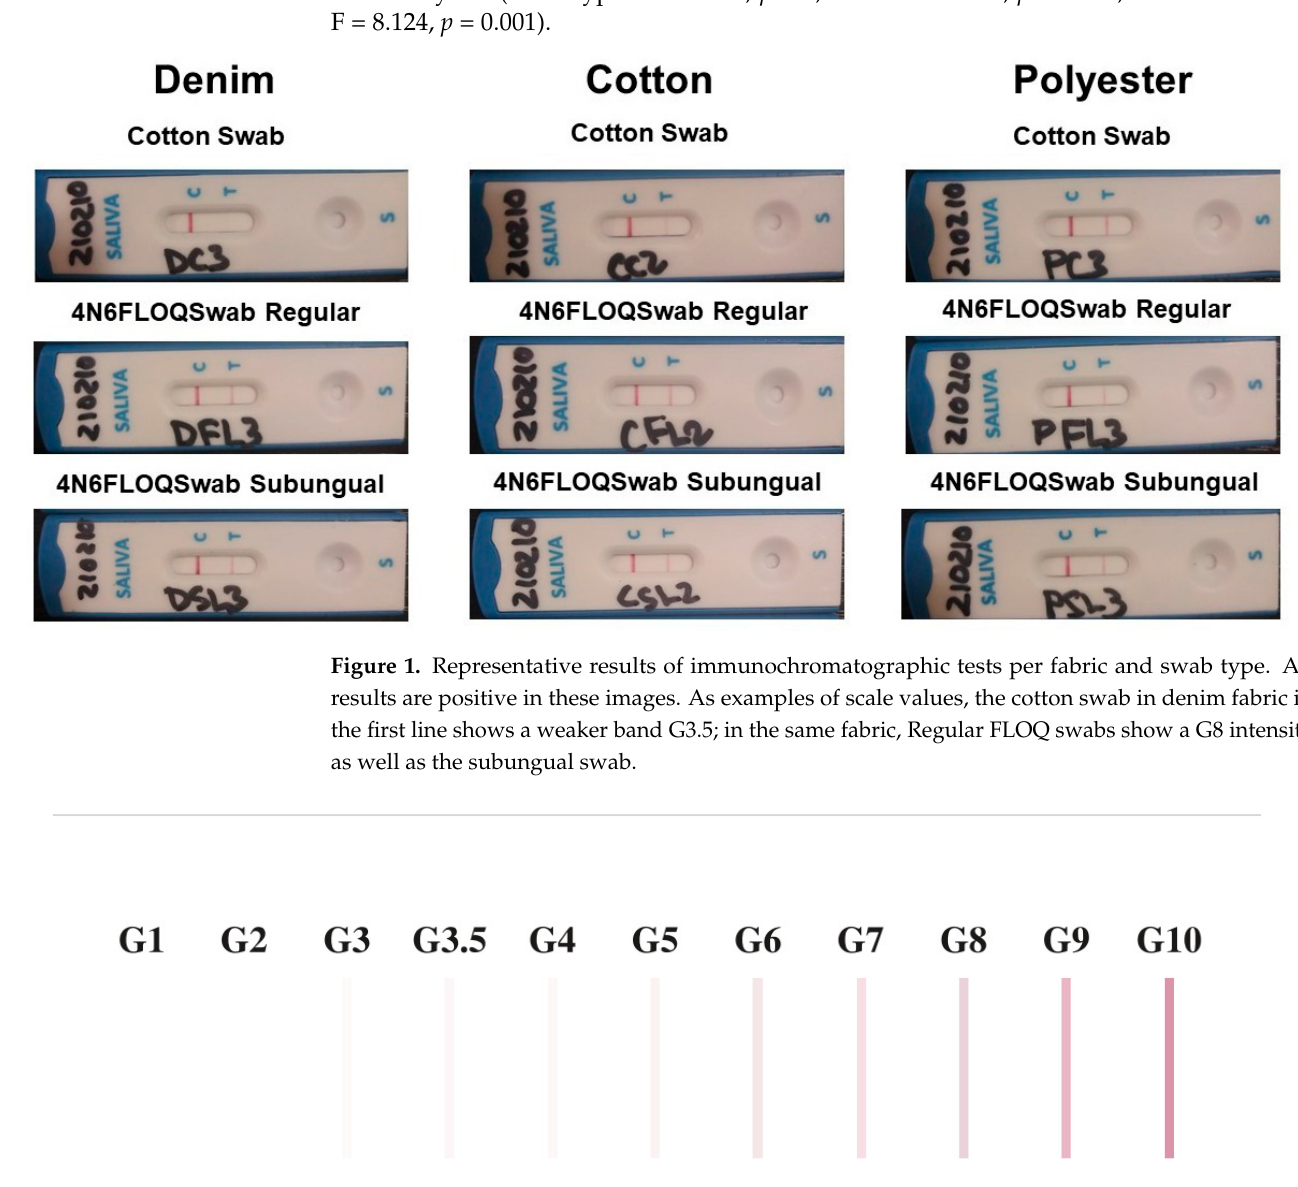
Figure 2. Scale to assign rank values to the immunochromatographic test signal intensity. G3.0 and over are considered positive values to the presence of the protein in question. This scale is used for comparative purposes and analyses only in a fixed experimental design. It was used and tested previously as Internal Quality control from SERATEC © (personal communication).